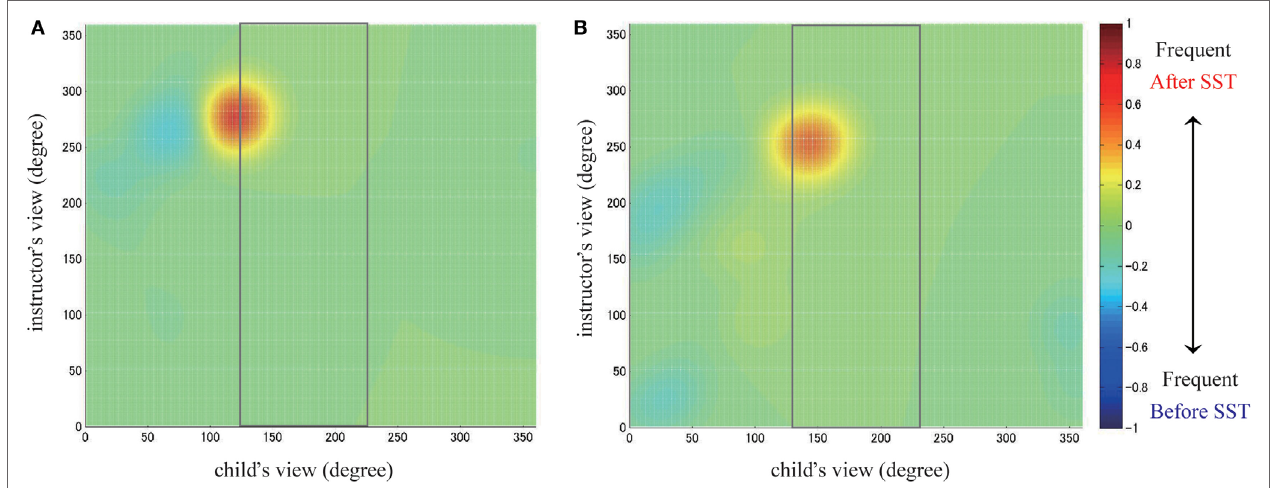
FiguRE 3 | Pre–post comparisons of pre-helping behavior in children with ASD (difference map). (a) Child A. (B) Child B. Brighter colors (toward red) indicate that values of frequency in that region increased after the intervention. The area indicated by the gray rectangle indicates the range of x -axis (in degrees) where the instructor was in front of the child. Both children looked straight at their instructor more often after